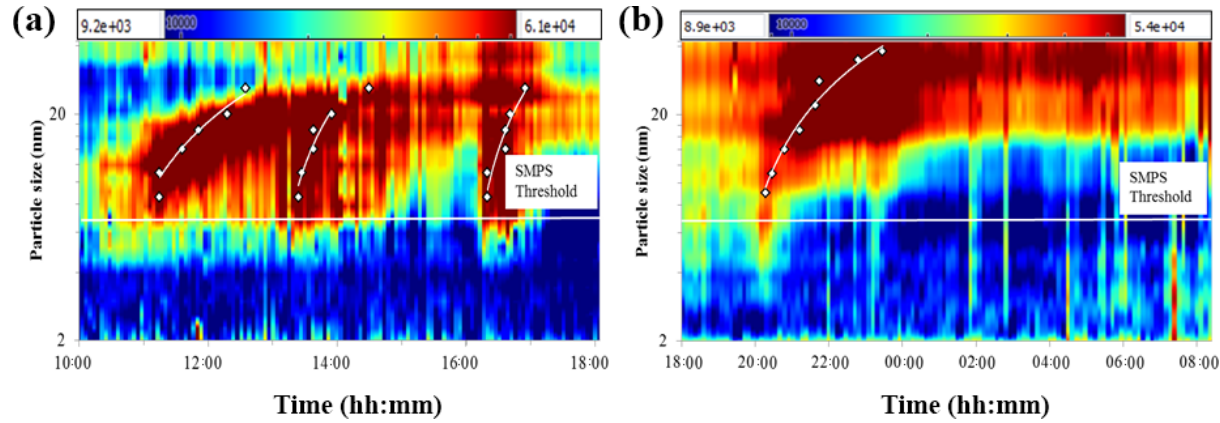
Figure 3. NAIS spectrograms of the growth events that occurred during (a) day time (b) night time. Note the “floating banana” shape, which indicates that these are clearly not NPF events. The SMPS cannot detect particles at sizes below the horizontal white line. The colour contour represents the PNC and the markers represent the times at which the PNC reached its maximum value at each particle size. The unit of PNC is per cubic centimetre.